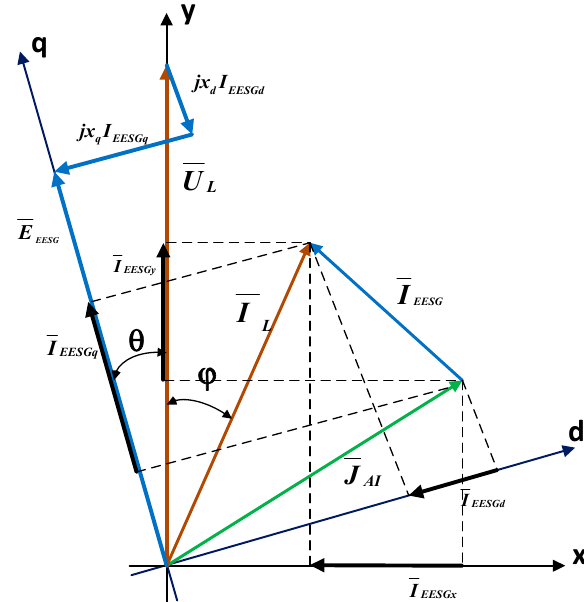
Figure 7. General vector diagram of the EESG mechatronic system with SGAR+AI.